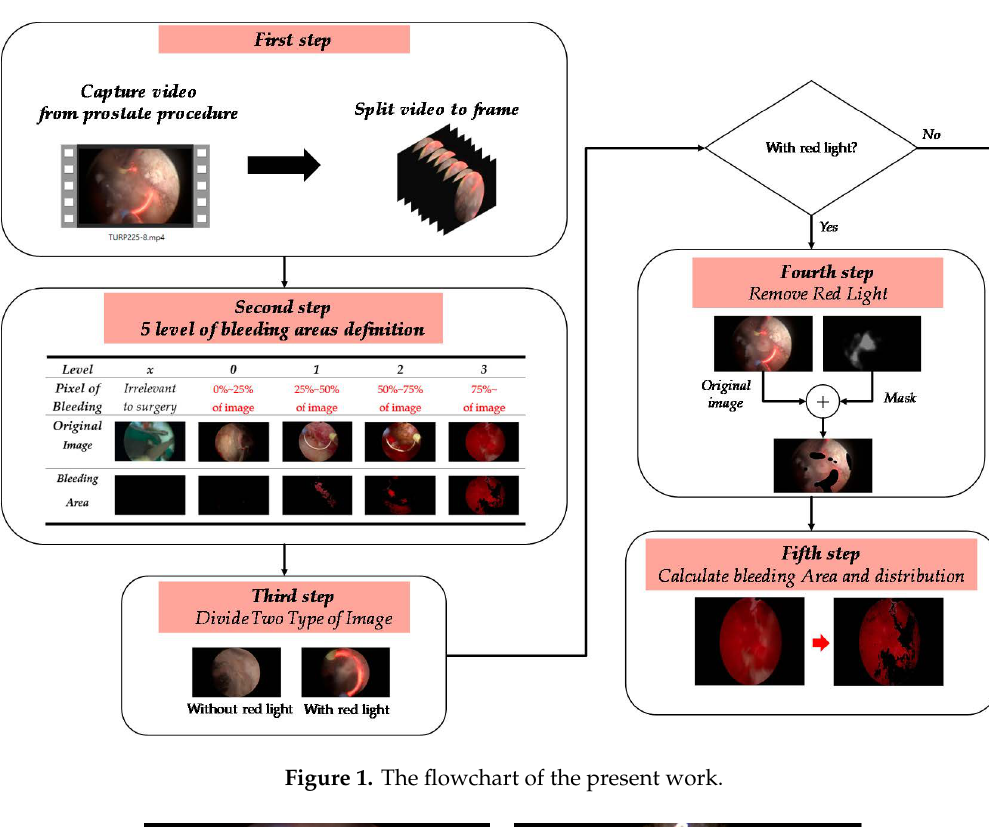
Figure 1. The flowchart of the present work.